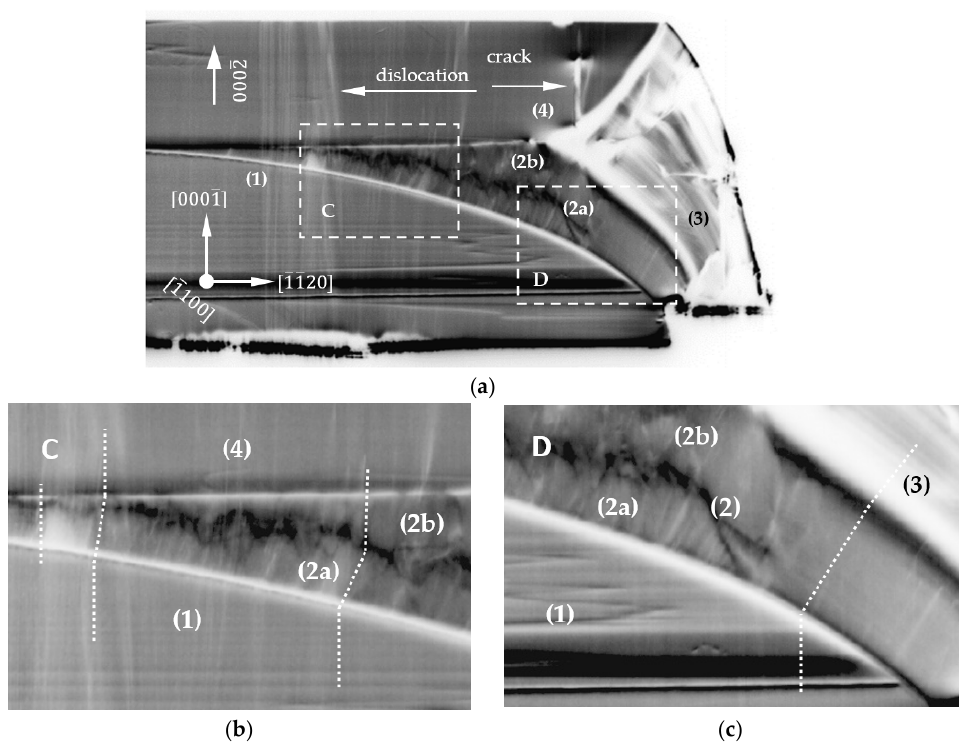
Figure 7. X-ray topographs of the 1100 slice. To image the 0002 reflection, Cu-K α 1 radiation was used: ( a ) overview topograph of the 1100 plane; five areas separated by clear interfaces were visible, as in Figure 3a,b; one crack was also present. Magnified images of sectors presented in Figure 7a: ( b ) sector C, where the dislocations from area (1) went straight to area (4) and the two-stage dislocation refraction in area (2) (considered as the sum of areas 2a and 2b); ( c ) sector D, where the two-stage dislocation refraction went from area (1) to area (3).